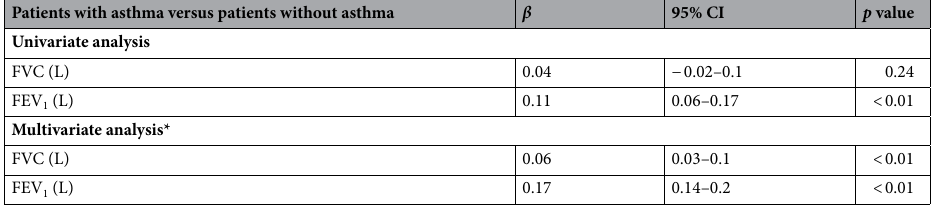
Table 2. Univariate and multivariate analyses of FVC and FEV 1 in patients with asthma versus patients without asthma. FVC, forced vital capacity; FEV 1 , forced expiratory volume in 1 s; CI, confidence interval. *FVC and FEV 1 were individually adjusted by confounding factors including height, age, sex, and smoking history.